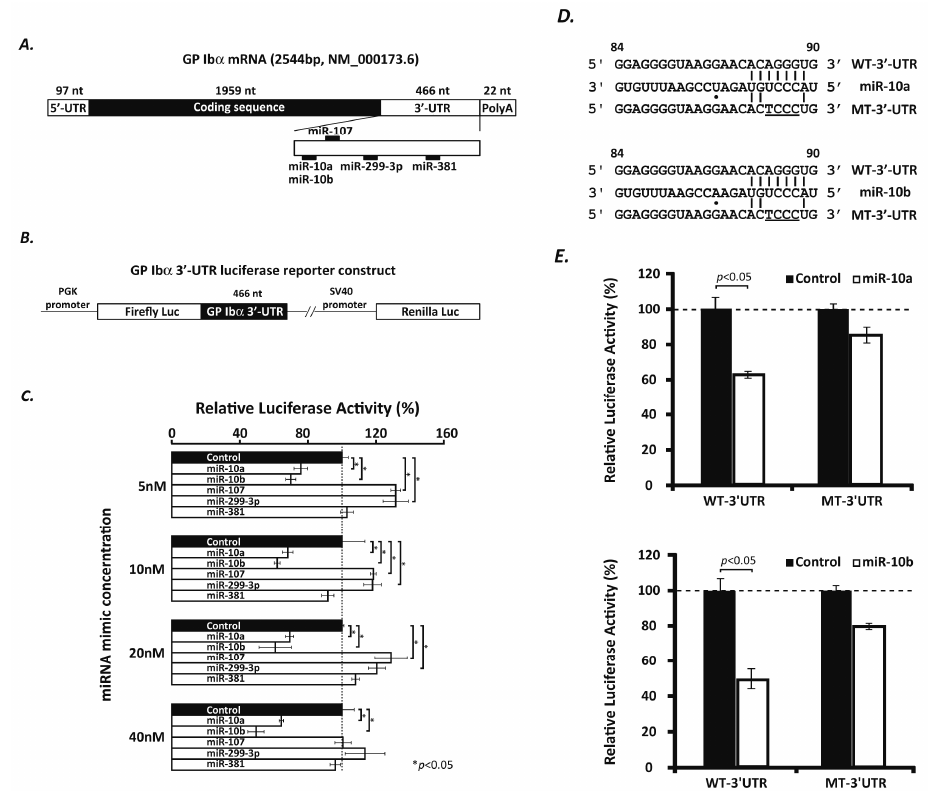
Figure 1. miR-10a and -10b target the 3 ′ -UTR of the human GP1BA gene. ( A ) Schematic view of the 2054 nt (nucleotides) mRNA transcript of the human GP1BA gene illustrating the location of the coding sequence and the predicted binding sites for miR-10a, -10b, -107, -299-3p and -381 in the 3 ′ -UTR; ( B ) Schematic view of the wild type reporter construct (WT-3 ′ -UTR) that harbors a 466 nt region of the wild type human GP1BA 3 ′ -UTR inserted downstream of a firefly luciferase coding sequence. Because the renilla luciferase gene is independently transcribed, it serves as an internal control in the luciferase assay; ( C ) Hela cells were co-transfected with 0.2 µg WT-3 ′ -UTR reporter plasmid DNAs along with a series of concentrations (5, 10, 20 and 40 nM) of miRNA mimics (miR-10a, -10b, -107, -299-3p, and -381). Only the miR-10a and -10b mimics can significantly (* p < 0.05) reduce the firefly luciferase activity in a dose-dependent manner. Mean activities of firefly and renilla luciferases were measured 40 h after transfection and presented as ratios of firefly to renilla luciferase activity. Standard errors (±SEM) were calculated from three independent experiments in triplicate ( n = 3); ( D ) Base pairing of miR-10a and -10b with their predicted target sites in the 3 ′ -UTR of the human GP1BA gene. The mutations introduced to the seed sequence of a WT-3 ′ -UTR are underlined; miR-10a and -10b differ in only one nucleotide (dotted); ( E ) The inhibitory effects of miR-10a and -10b mimics (40 nM) on firefly luciferase activities were greatly inhibited when the mutant reporter constructs (MT-3 ′ -UTR) were used. The Student t test and analysis of variants were used to assess differences. p < 0.05 is considered as significant.